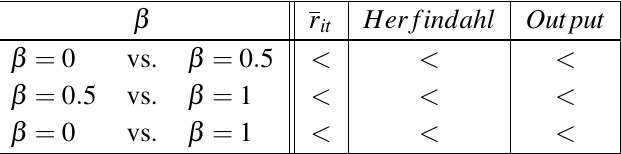
Table 2: Impact of